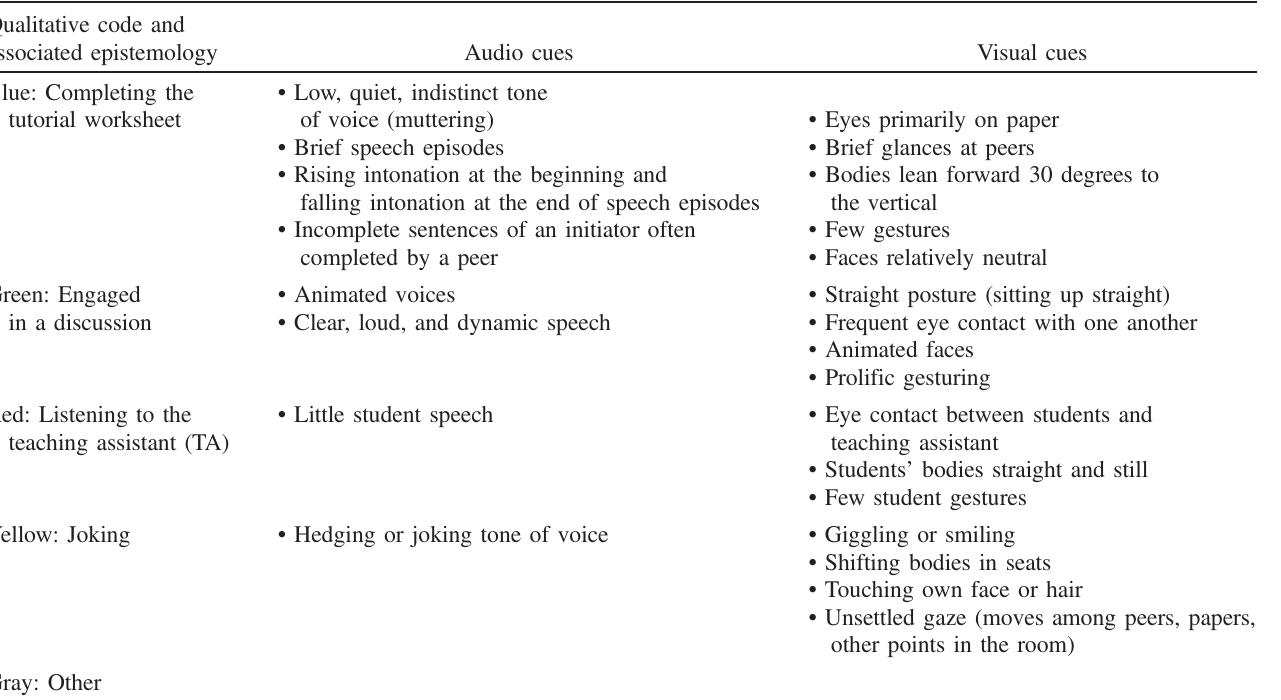
TABLE I. Summary of behavioral clusters first identified by Scherr and Hammer